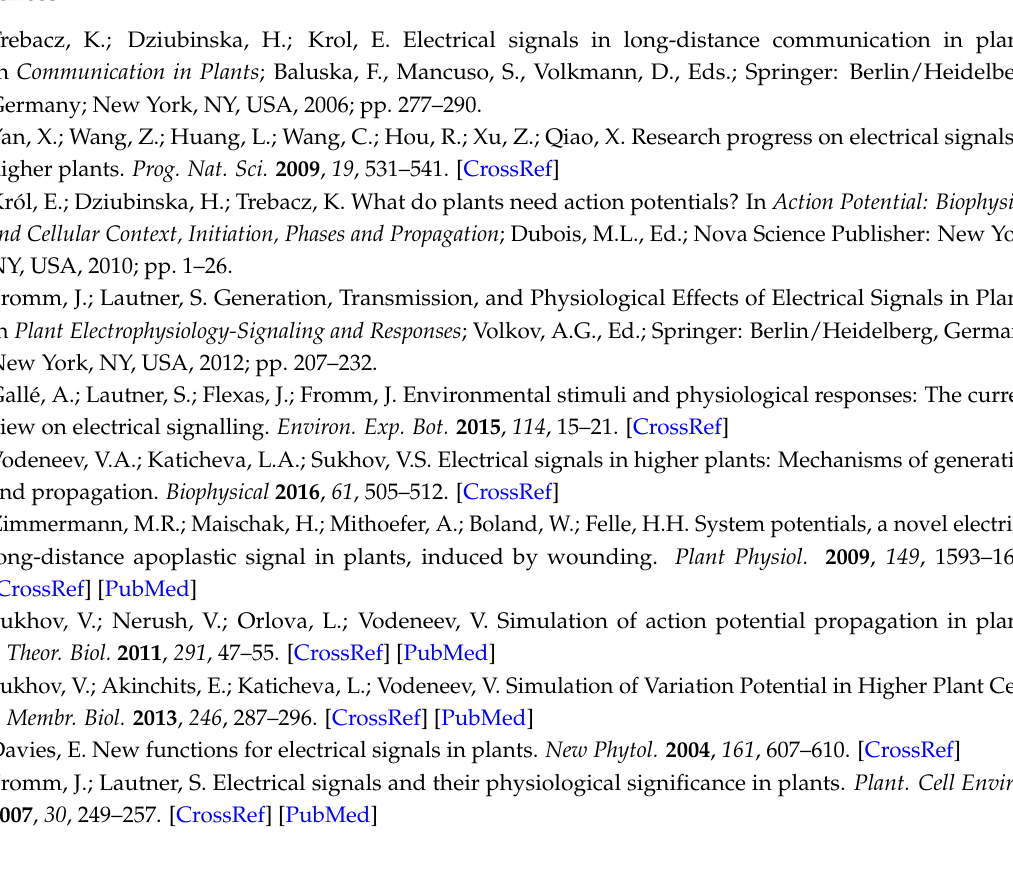
Figure S1: APs extracted from composite signals involving both APs and VPs induced by burning